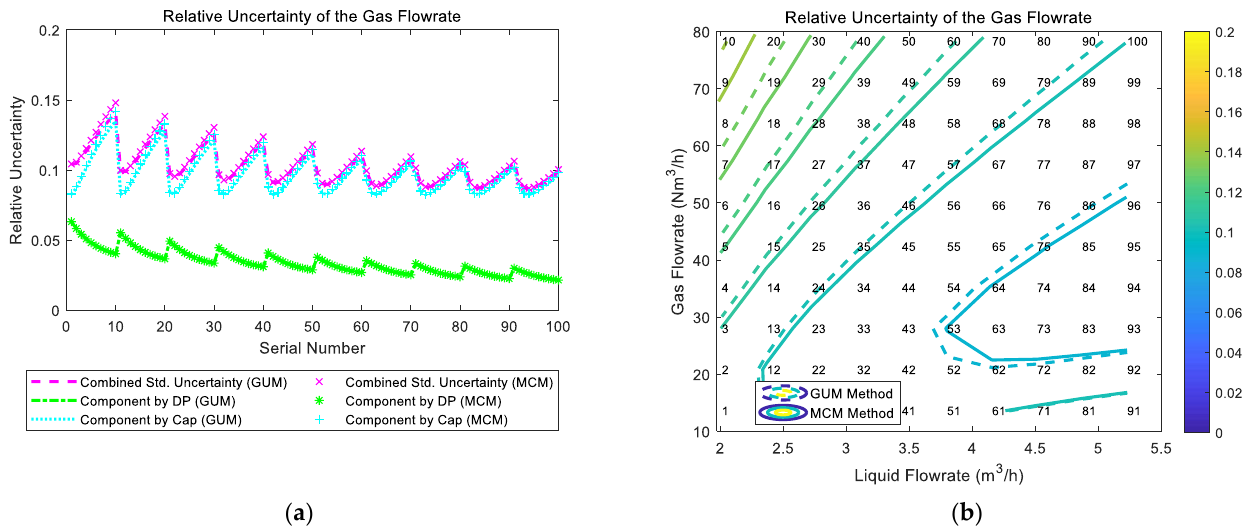
Figure 12. The composition and distribution of the relative uncertainty of the gas flowrate of the “DP + Cap” method: ( a ) composition diagram; ( b ) distribution diagram. (Each contour line denotes an increment of uncertainty of 0.01. More information about the composition and distribution can be found in Section 2.4.1).